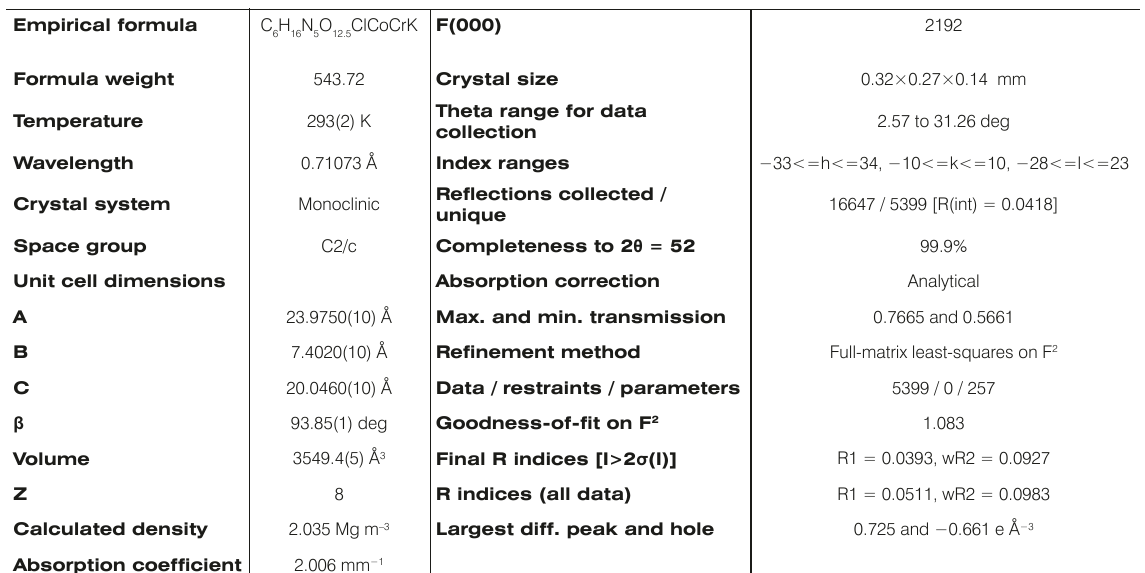
) ][KCr(C O ) ] •0.5H O ( 1 ). 3 5 2 4 3 2